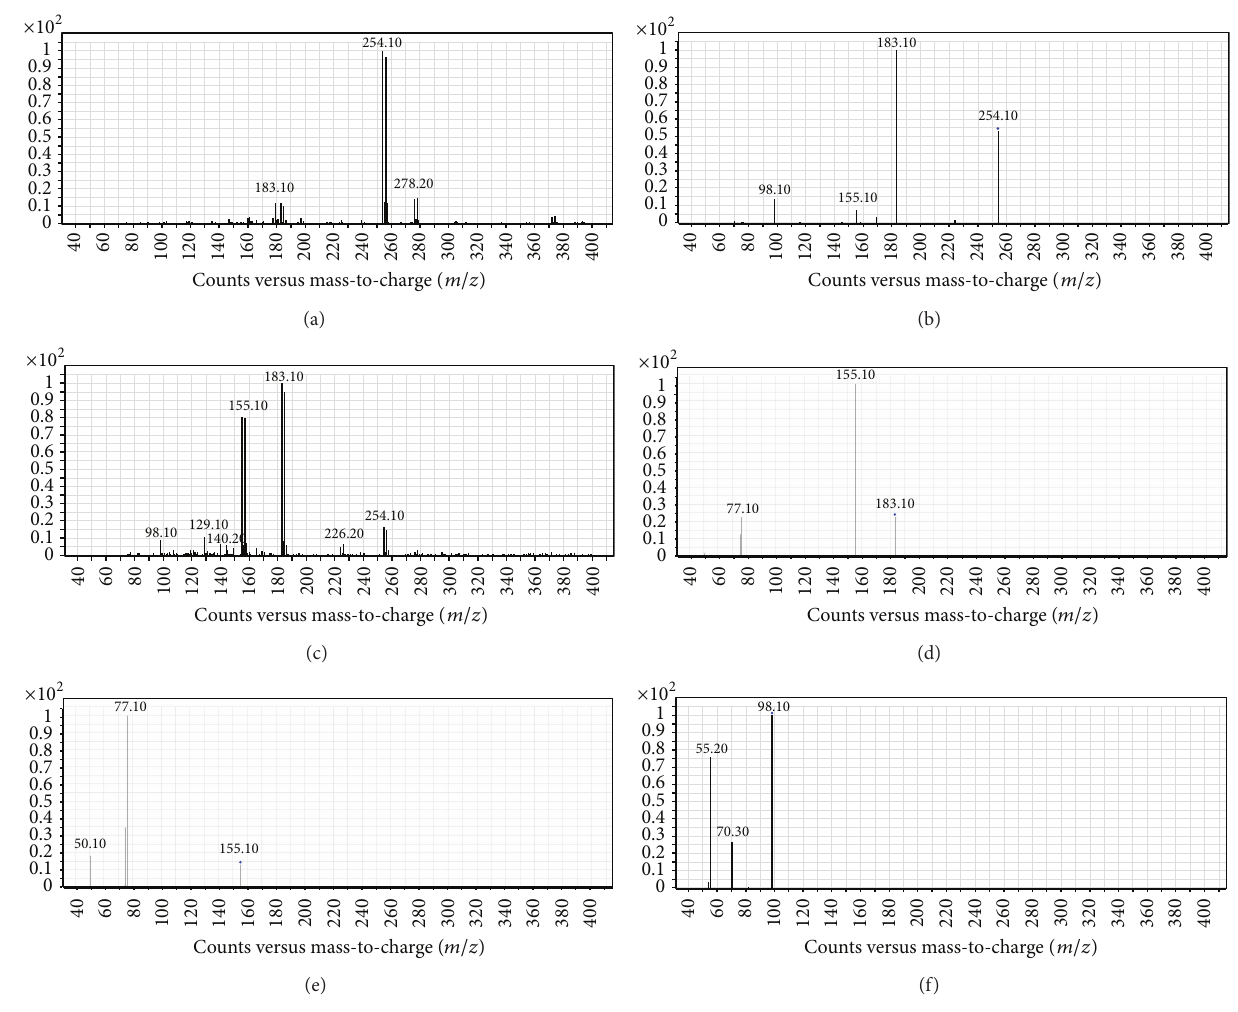
Figure 2: (a) ESI mass spectrum of compound 4f [M + H] + ion ( m/z 254.10). (b) MS 2 spectrum of m/z 254.10. (c) In-source fragmentation of compound 4f . (d) MS 2 spectrum of m/z 183.10. (e) MS 2 spectrum of m/z 155.10. (f) MS 2 spectrum of m/z